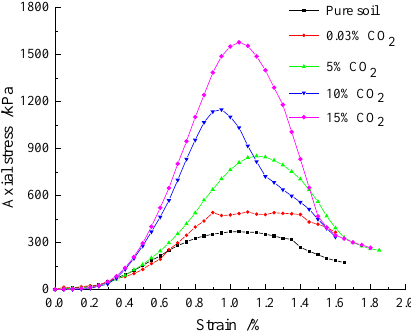
Figure 6. Stress–strain curves of the simulated site soil under different CO 2 concentration curing conditions.